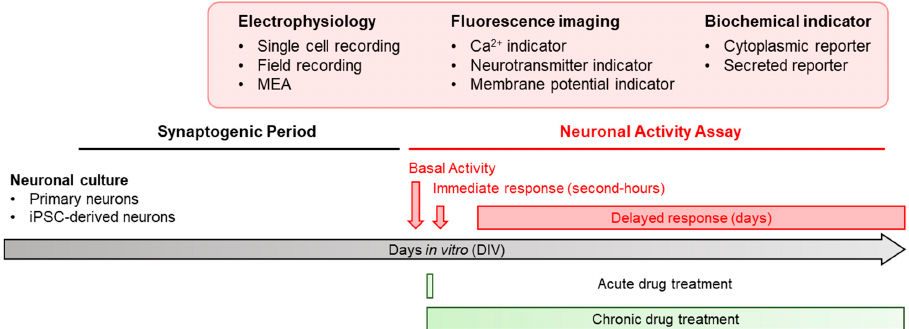
Figure 1. In vitro neuronal activity assay as drug screening platforms. Primary neurons derived from laboratory animals or induced pluripotent stem cell (iPSC)-derived human neurons are cultured and matured in vitro. After the synaptogenic period, neuronal activity can be measured by a variety of neuronal activity assays, including electrophysiological assays, fluorescence-based imaging, and/or biochemical assays. The acute and delayed effect of the drug treatment on neuronal activity can be monitored immediately or longitudinally for multiple days, respectively, depending on the invasiveness of assays and the capability of comparing the baseline activities over time. Table 1. Comparing neuronal activity assays for their applicability to high-throughput drug screening in vitro .